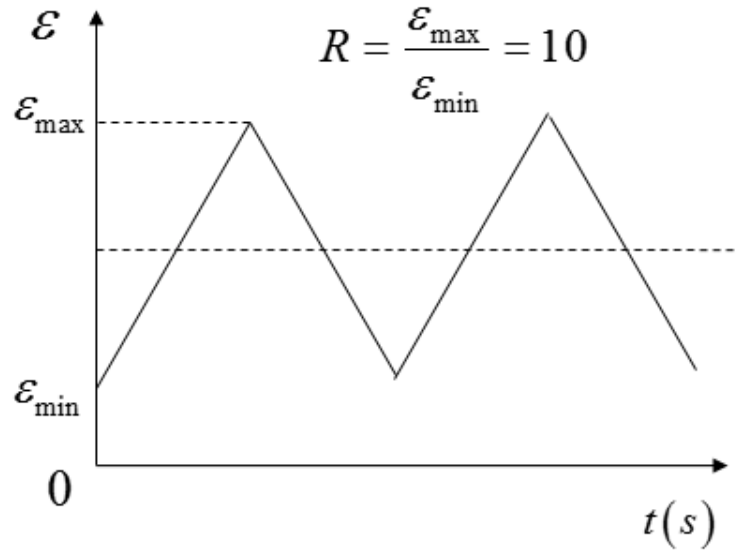
Figure 5. Loading waveform for fatigue test of High Modulus Asphalt Concretes (HMAC).